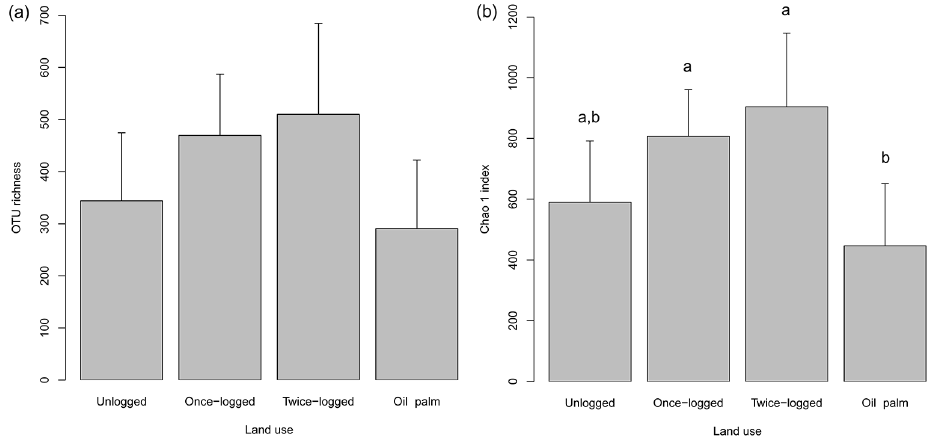
Figure 1. Diversity indices of the fungal community across different land uses in Sabah, Malaysian Borneo. (a) OTU richness and (b) Chao1 index. Pairwise comparisons are shown; different letters denote significant differences between groups at P , 0.05.